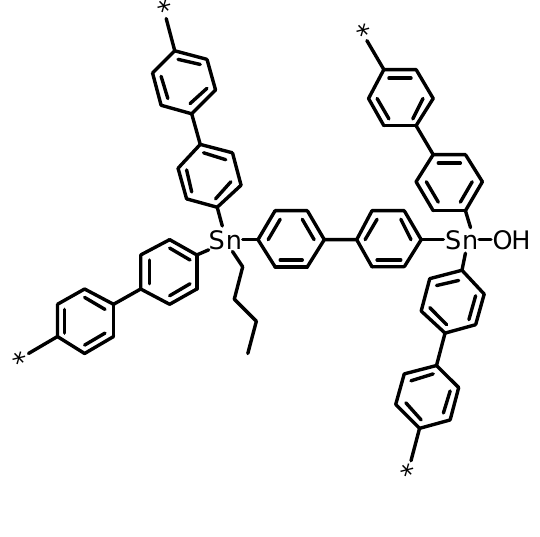
Scheme 2. Schematic representation of the three-dimensional framework structure of EOF-3 including additional aliphatic and hydroxy